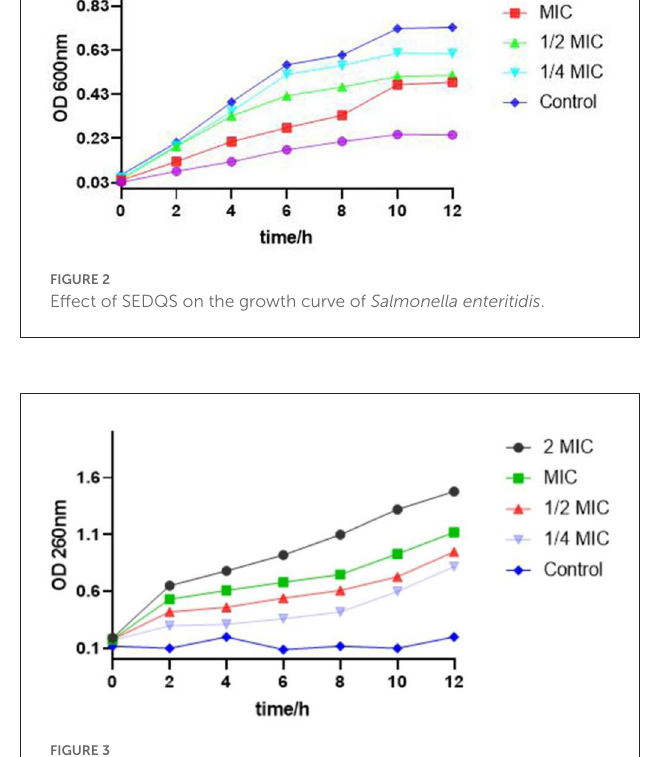
FIGURE3 The change about OD of nucleic acid substance from Salmonella enteritidis affected by SEDQS.